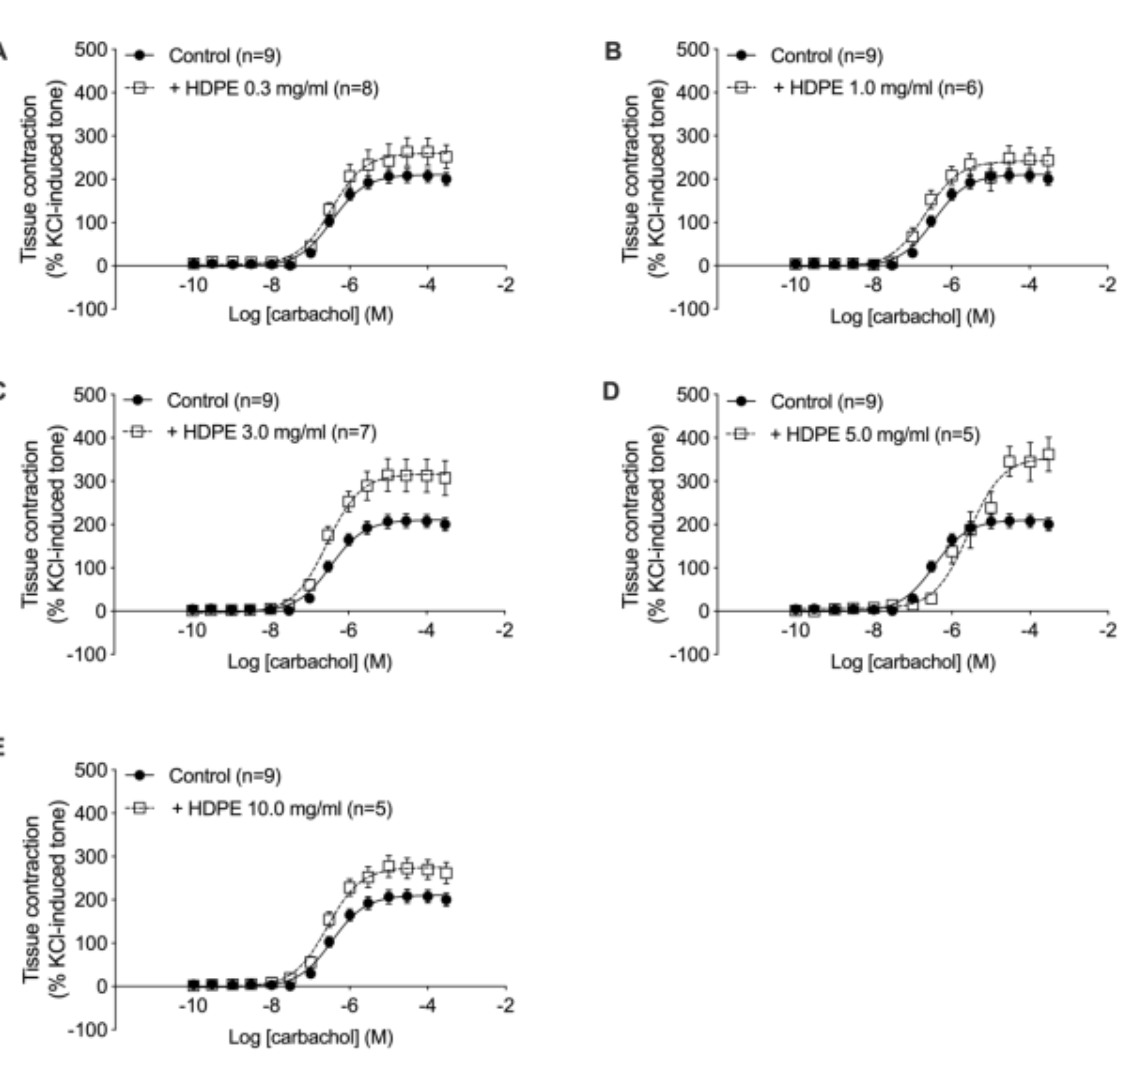
Figure 2 : Effect of overnight incubation with high-density polyethylene (HDPE) microplastics on carbachol- induced contractions in isolated rat trachea. Tissues were incubated overnight in Krebs solution (control) or Krebs solution with HDPE microplastics (A) 0.3 mg/ml, (B) 1 mg/ml, (C) 3 mg/ml, (D) 5 mg/ml, (E) 10 mg/ml. Cumulative concentration-response curves to carbachol were constructed following overnight incubation. Tissue contractions were expressed as a percentage of 60 mM KCl-induced tone and shown as mean ± SEM of n number of